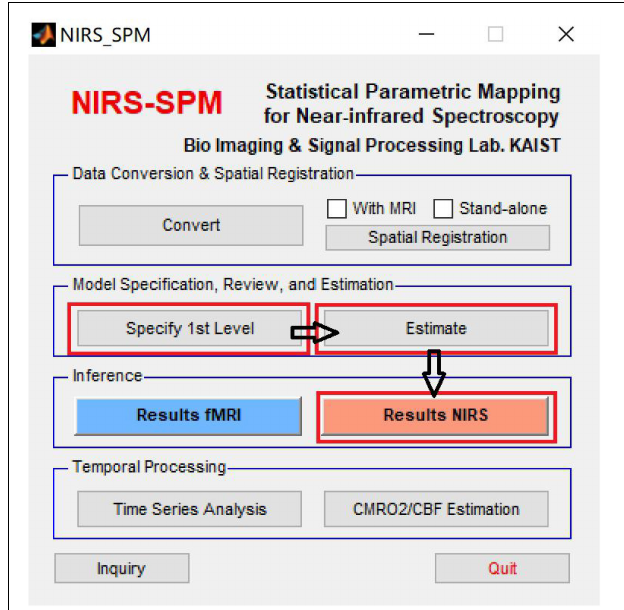
FIGURE 5 | NIRS_SPM plug-in running